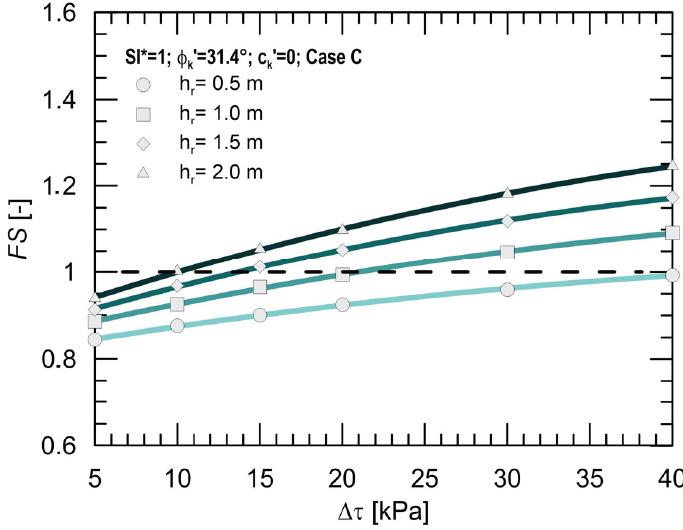
Figure 3. Factor of safety trend for ϕ k ′ = 31.4° and seismic case C.